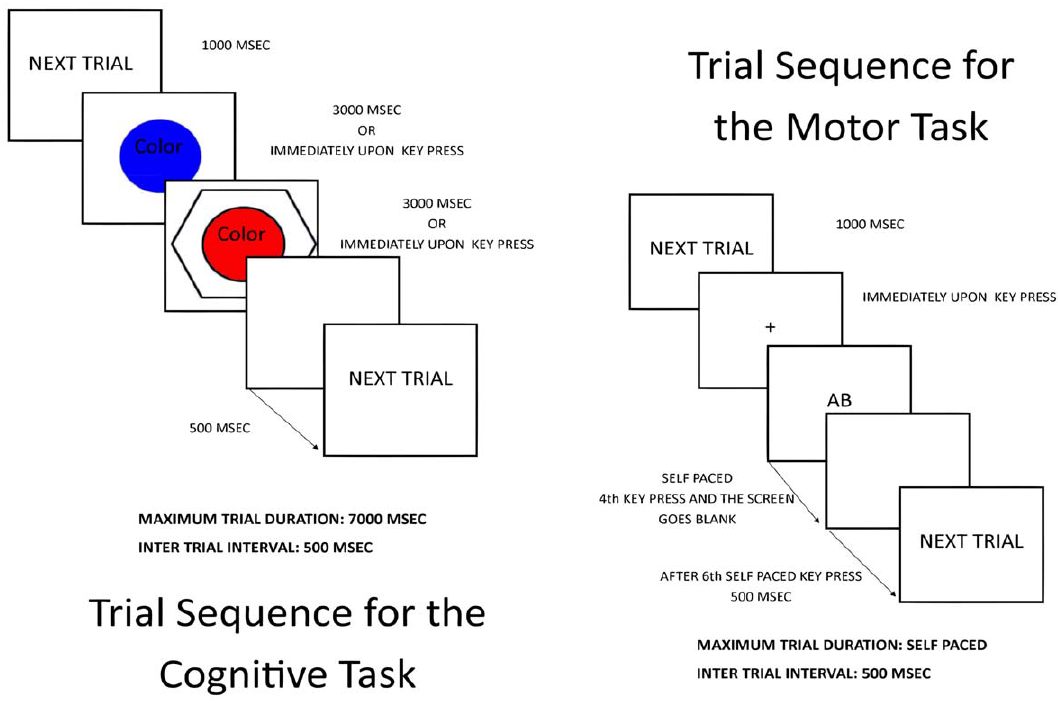
Figure 4. Schematic Representation of the tasks used in the experiment. Each trial started with a next trial message on the center of the screen. Cognitive task: In this task, each trial consisted of a pair of stimulus. The set that the participant was required to respond could remain the same (e.g. Color S1 and Color S2) or could be different (e.g. Shape S1 and Color S2). Motor Task: In each trial a pair of letters appeared on screen (each letter represents a motor sequence of three key presses previous